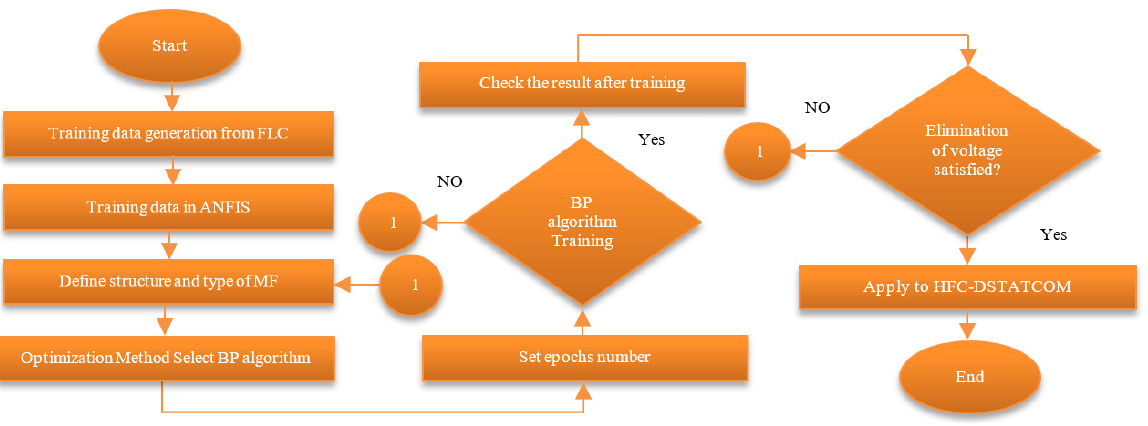
Figure 18. Flowcharts of ANFIS.